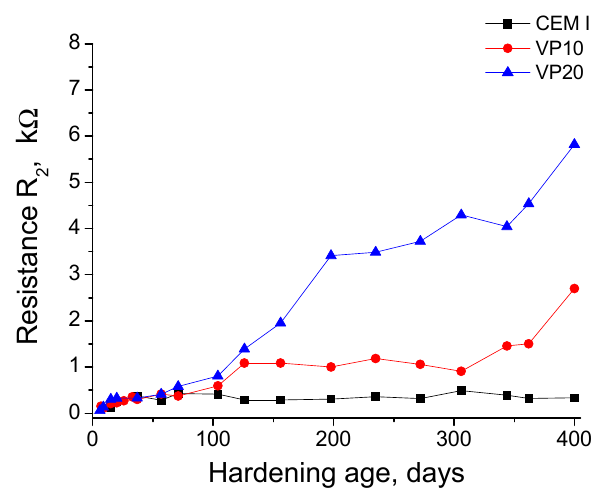
Figure 10. Impedance spectroscopy R 2 resistance for the mortars studied.